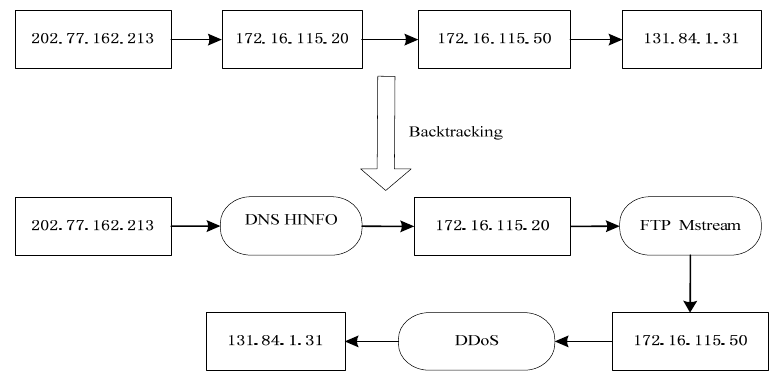
Figure 8. The Evidence Graph of LLDOS 2.0.2 Dataset (Omission of DDoS Attack).